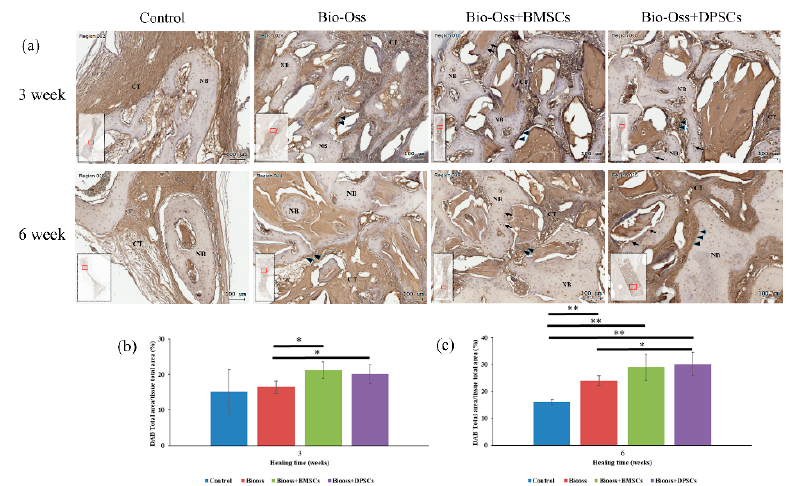
Figure 9. ( a ) Images of Collagen I immunostaining in bone defects in control, Bio-Oss, Bio-Oss+BMSC, and Bio-Oss+DPSC groups at 3 and 6 weeks. The black arrowheads indicate osteoblasts at the interface between the bone grafting materials and the newly-formed bone. Collagen I immunostaining percentages in defect region at ( b ) 3 weeks and ( c ) 6 weeks after surgery as assessed by DAB total area/tissue total area analyses. (NB = new bone; GM = graft material; CT = connective tissue. Scale bars = 100 μ m.) (* p < 0.05, ** p < 0.01.).